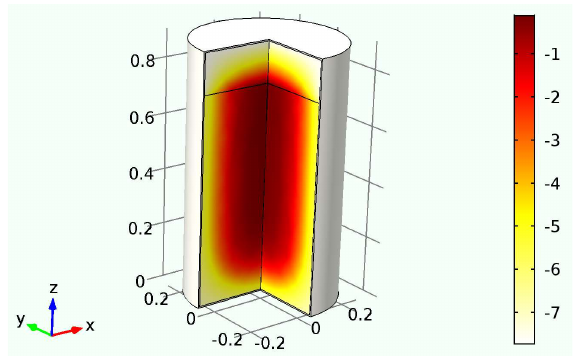
Figure 6. Temperature (°C) distribution in the barrel filled with CPB after 72 h of curing in the cold room.